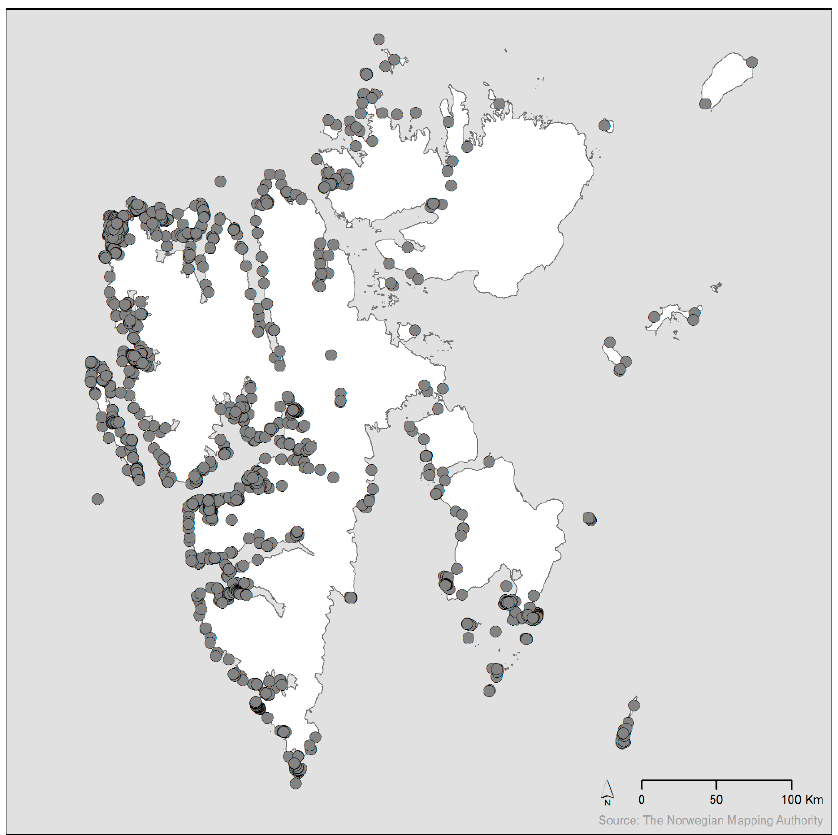
Figure 1. Maps of cultural heritage sites in Svalbard (map by Alma Thuestad, NIKU).